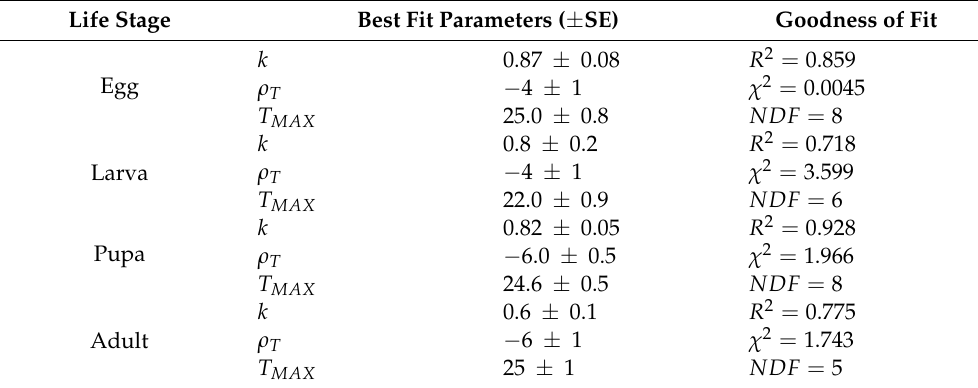
Table 2. Mortality rate function (7) best-fit parameters and their associated standard errors for egg, larva, pupa, and adult stage. The goodness of fit was based on the χ 2 -test, the coefficient of determination R 2 , and the number of degrees of freedom (NDF). The best fitting functions are plotted in Figure 3.